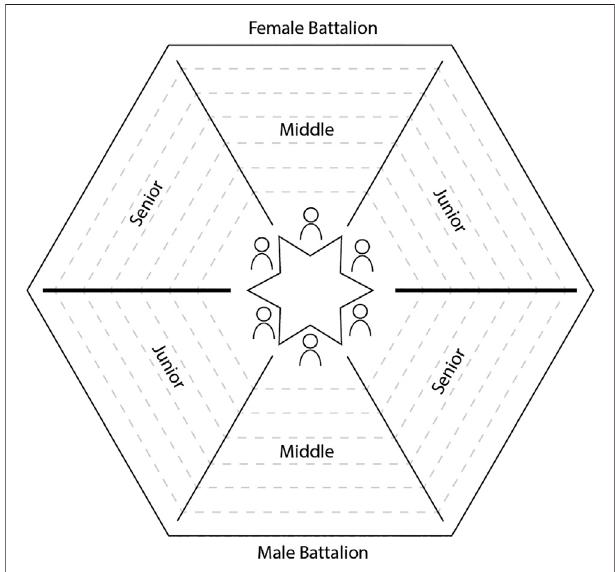
FIGURE 1 | Spatial arrangement of SD